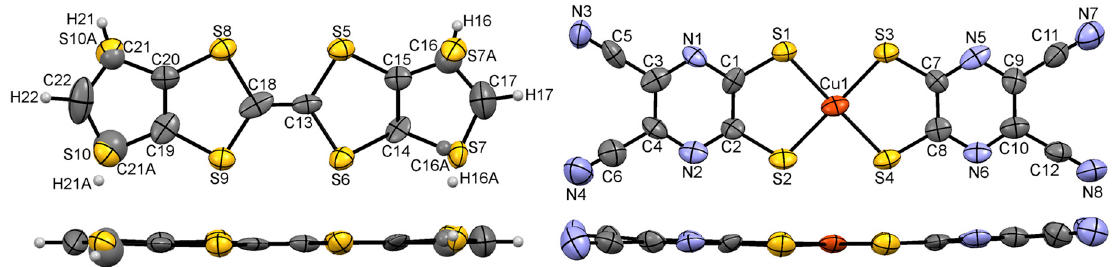
Figure 3. ORTEP and atomic numbering schemes (top and side views) of donor molecules and acceptor [Cu(dcdmp) 2 ] in the crystal structure of α -DT-TTF[Cu(dcdmp) 2 ] ( 3 ), with thermal ellipsoids drawn at 70% probability level.